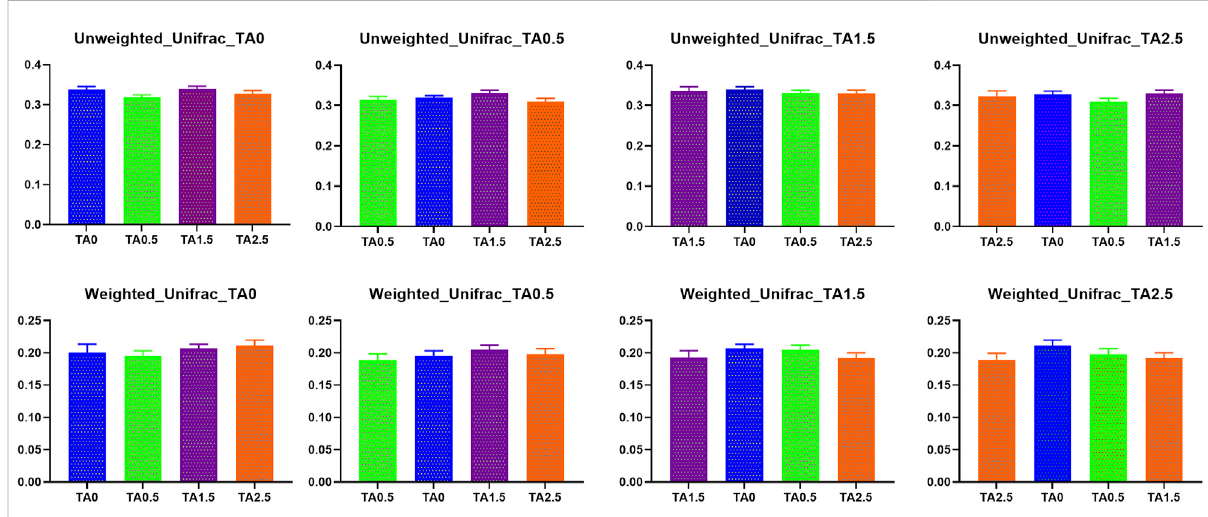
FIGURE 11 Betadiversityindices(WeightedandunweightedUnifrac)ofthececalmicrobialcommunitiesinthebroilersofthetannicacid0(TA0):basaldiet withouttannicacid;2)tannicacid0.5(TA0.5):basaldietwith0.5 g/kgtannicacid;3)tannicacid1.5(TA1.5);and4)tannicacid2.5(TA2.5)groupsonD 21. The treatment groups were compared using one-way ANOVA followed by the Tukey ’ s multiple comparison. Different superscripts differ at p <